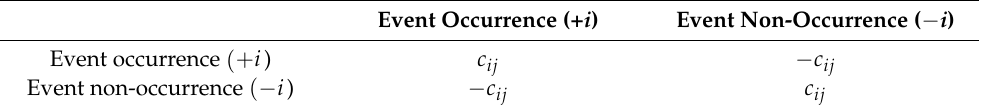
Table 3. The matrix transformation table. Event Occurrence (+ i ) Event Non-Occurrence ( − i ) Event occurrence (+ i ) c ij − c ij Event non-occurrence ( − i ) − c ij c